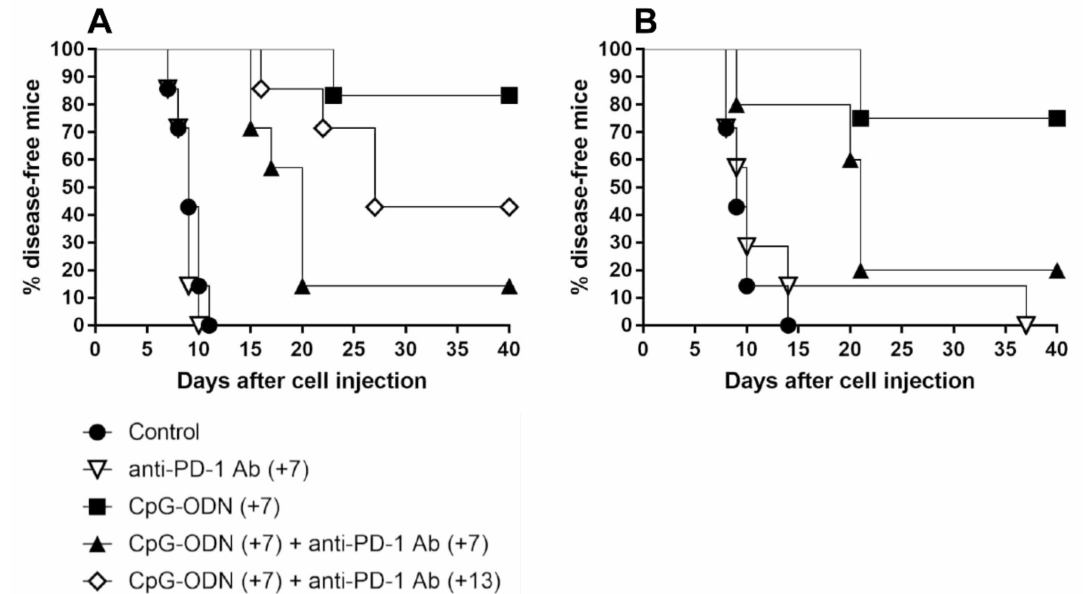
Figure 2. Kaplan–Meier plot of percent disease-free IGROV-1 ovarian tumor-bearing mice treated with CpG-ODNs, an anti-PD-1 antibody or their combination. ( A ) Mice xenografted with IGROV-1 human ovarian cancer cells were treated i.p. with CpG-ODNs (20 µ g/mouse, 5 days/week for 3 weeks, starting seven days after tumor cell injection), treated i.p. with an anti-PD-1 antibody (clone RMP1-24) (200 µ g/mouse, 2 times/week for 3 weeks, starting seven (+7) or thirteen (+13) days after tumor cell injection) or administered the combination of these treatments. ( B ) Mice xenografted with IGROV-1 human ovarian cancer cells were treated i.p. with CpG-ODNs (20 µ g/mouse, 5 days/week for 3 weeks, starting seven days after tumor cell injection), treated i.p. with an anti-PD-1 antibody (clone J43) (200 µ g/mouse, 2 times/week for 3 weeks, starting seven (+7) days after tumor cell injection) or administered the combination of these treatments. The control group received saline. Numbers in parentheses indicate the number of days between tumor cell injection and the administration of the first treatment. CpG-ODNs: CpG oligodeoxynucleotides; anti-PD-1 Ab: anti-PD-1